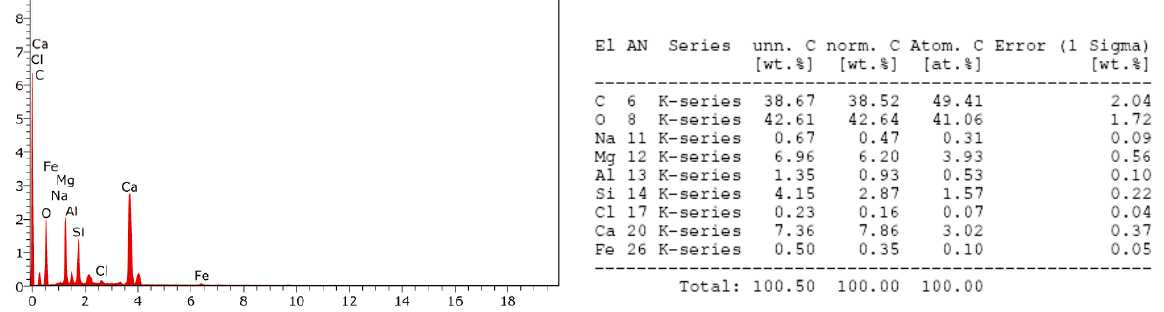
Figure 8. EDX analysis of TBM muck Sample #1.